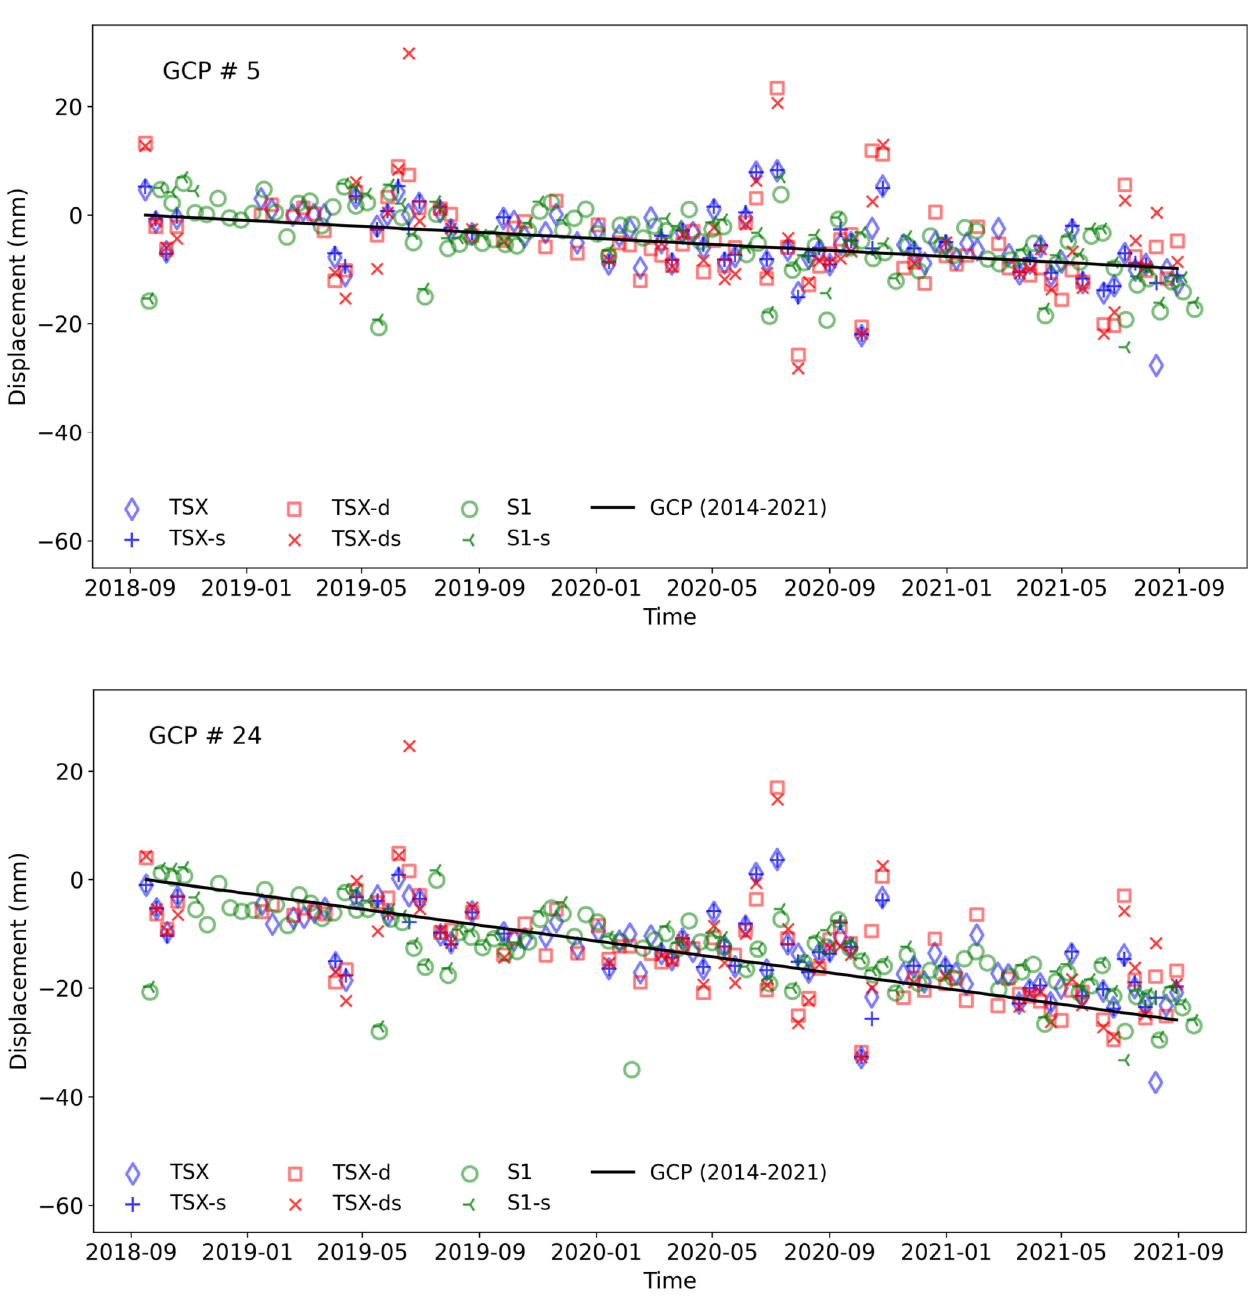
rates. Figure 8 illustrates a comparison between PSI-inferred deformation time series and GCP #24). The plots show a good agreement between the InSAR results and the surveying- ground surveying at two surveying stations (GCP #5 and GCP #24). The plots show a good based velocity. agreement between the InSAR results and the surveying-based velocity.